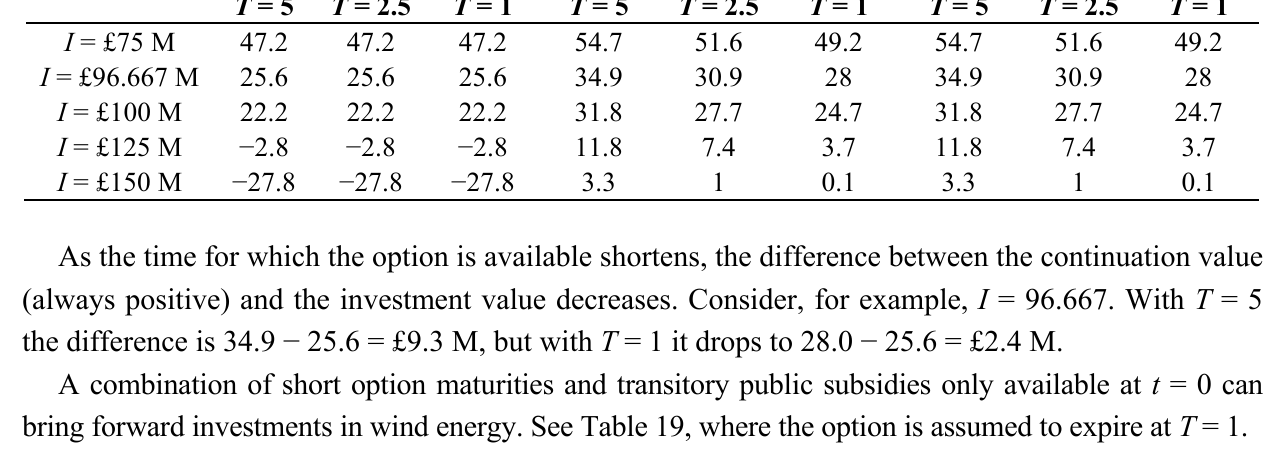
Table 19. Trigger cost I * as a function of a one-time subsidy S (£M) with T =